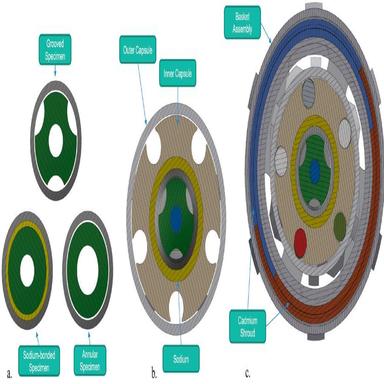
Shows cross-section views of a.) fuel rodlets, b.) inner and outer capsules, and c.) installation of experiment in a cadmium shrouded basket.